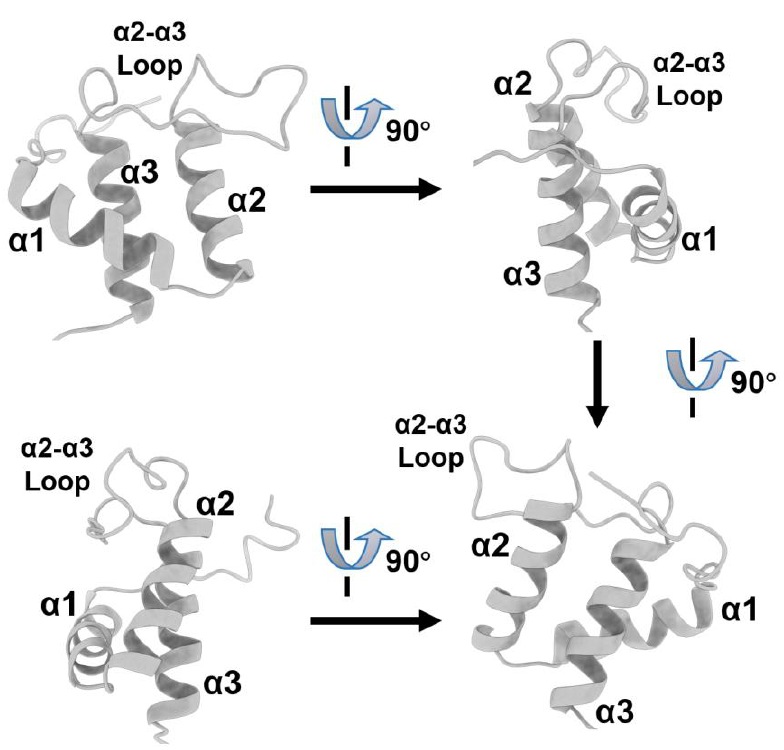
Figure 9. The annotations of secondary structures in the Brd4-ET domain. Alpha helixes ( α ) are indicated. The model is from the solution NMR structure of the Brd4-ET bound with MLV-IN EBM (PDB code: 2N3K).